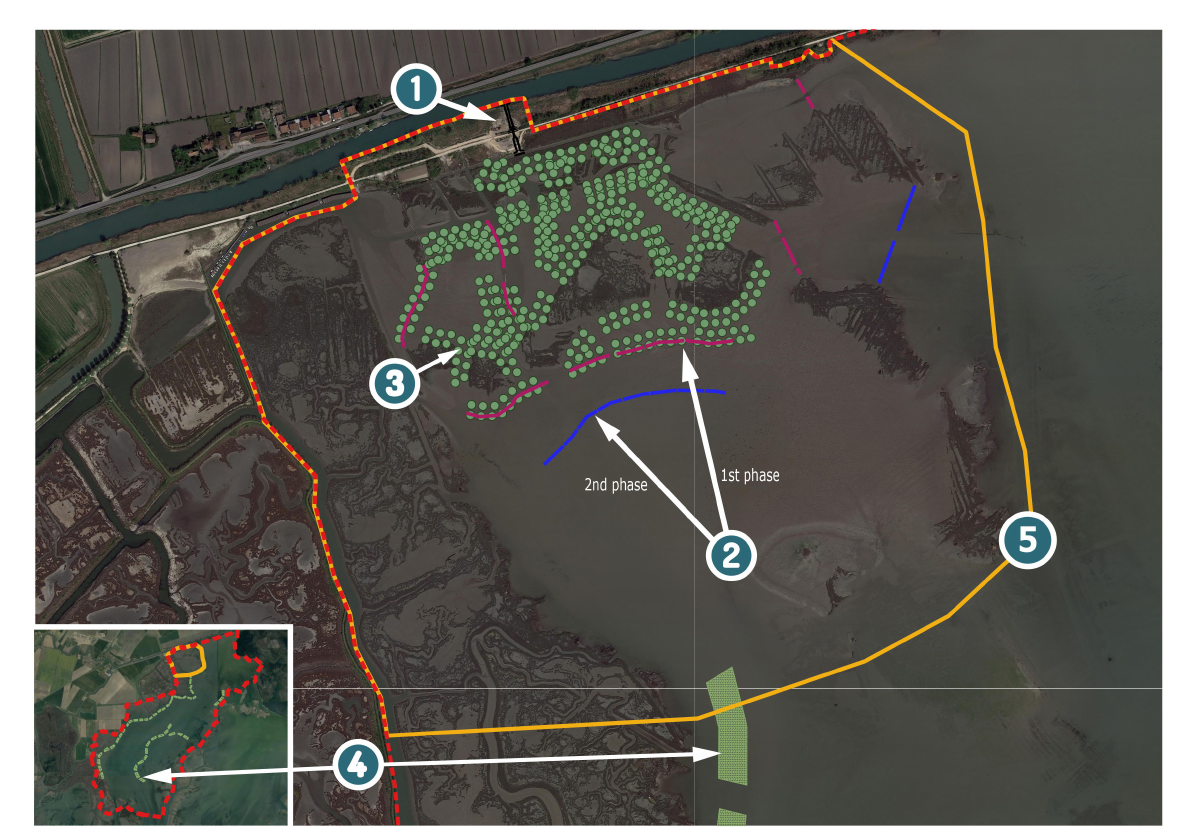
FIGURE2 Overall picture of the identified conservation actions of the Project. (1) Hydraulic works; (2) morphological works; (3) P. australis transplantation; (4) aquatic angiosperm transplantation; (5) area of reduction of hunting and fishing